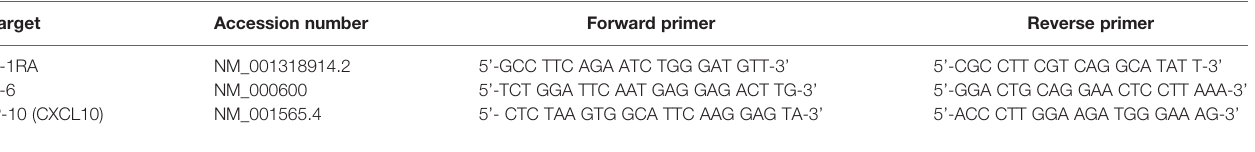
TABLE 2 | Primers used for gene expression